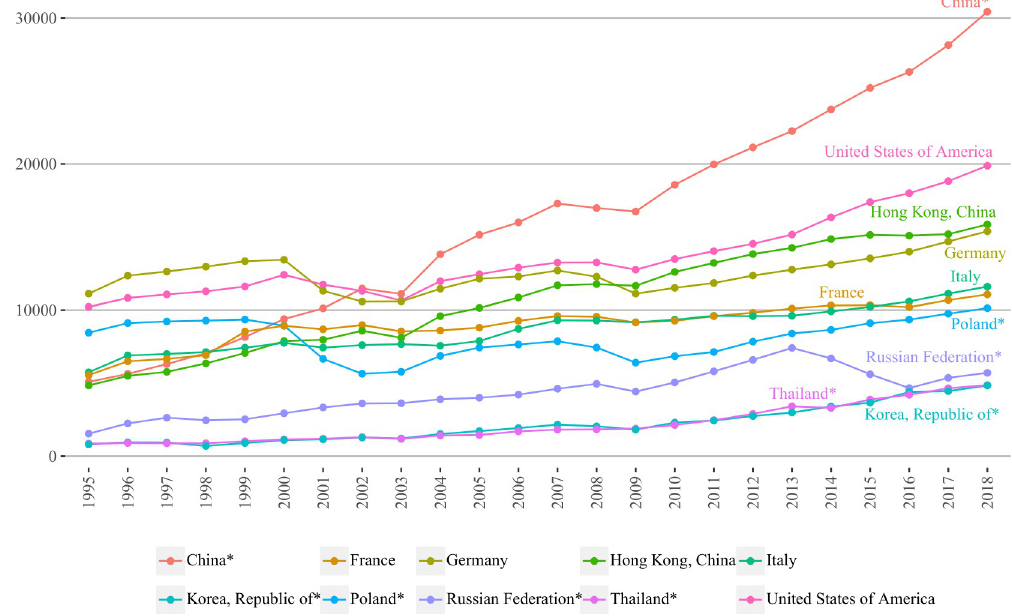
Fig 5. Strength centralities of top five BRI and non-BRI countries/regions over 1995–2018. In 10 thousand people, countries/regions are selected based on the highest values of 2018 years; BRI marked with ‘ � ’.